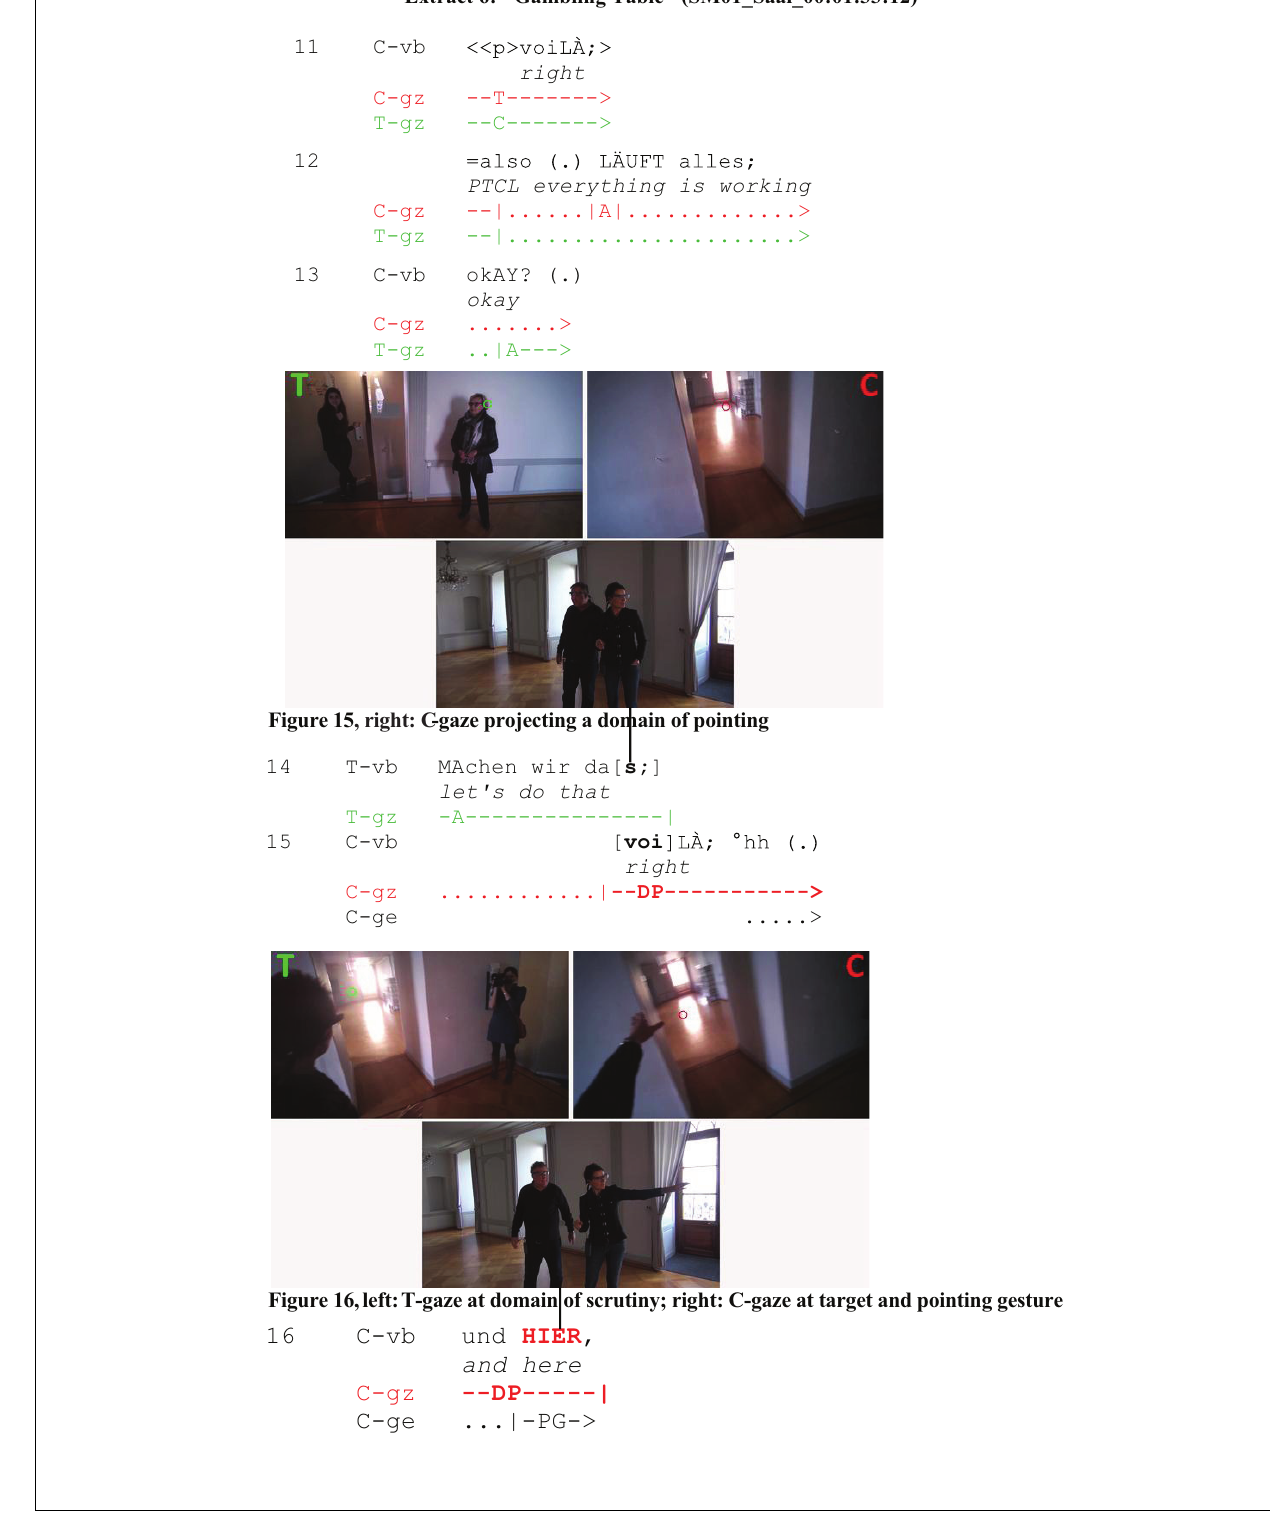
Figure 15, right: C-gaze projecting a domain of pointing